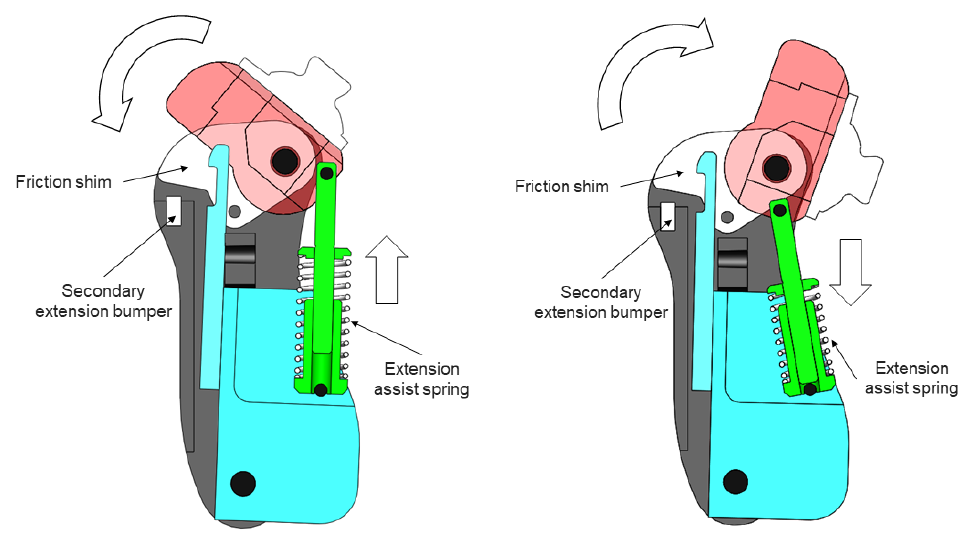
Figure 2. The main functional components of the variable cadence controller (VCC). Left: Increased friction and low spring force (and secondary extension bumper) decreases terminal impact near full extension; Right: Progressively increased friction (light pink area) and spring force with increase knee flexion helps to limit heel-rise and duration of swing-phase. The technical research details related to the development of the swing-phase controller can be found in [13,19].